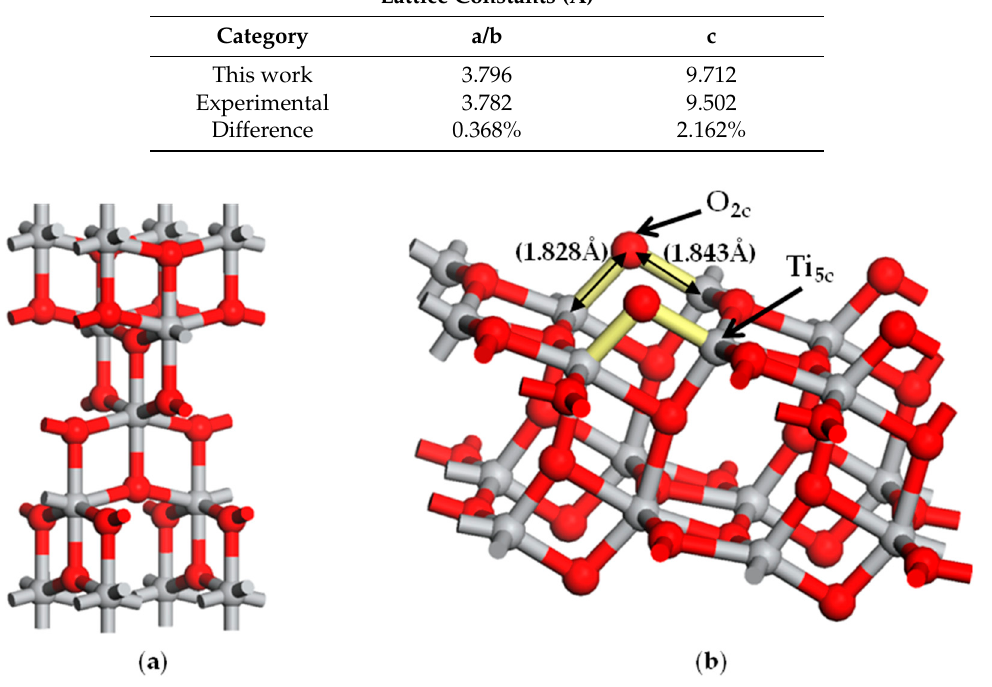
Figure 1. Model of the adsorbed structure: ( a ) the unit cell of anatase TiO 2 ; and ( b ) the slab of the anatase TiO 2 (101) plane, the distances represented in Figure 1b are the calculated lengths of the O 2c -Ti 5c bond (1.843 Å) and O 2c -Ti 6c bond (1.828 Å). Gray and red spheres represent Ti and O atoms, respectively.